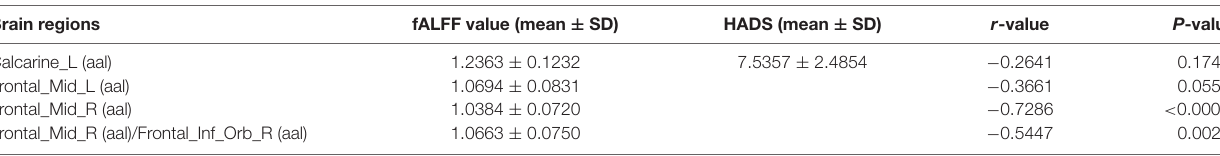
TABLE 3 | Pearson correlations analysis.